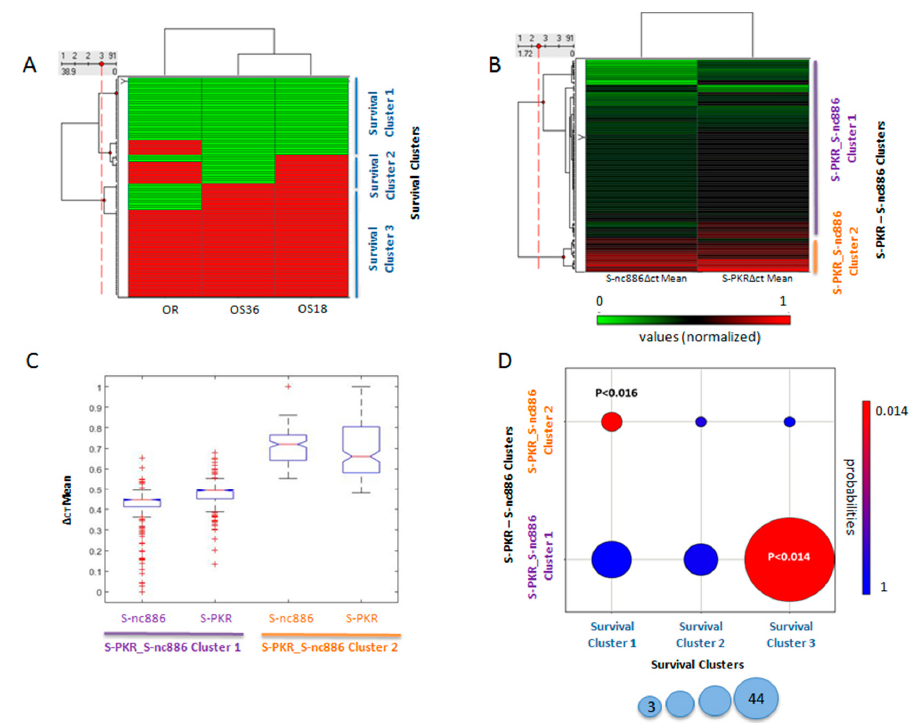
Figure 5. Correlation between the objective first-line chemotherapy response and the time-range patient survival with the ∆ ct mean values identified by RT qPCR in colon healthy (S) tissue. ( A ) Survival clusters: Biclusters of subjects according to their objective first-line chemotherapy response, and survival after 18 and 36 months. Values are coded as follows: negative response in green and positive response in red. ( B ) S-PKR-S-nc886 clusters: Biclusters of patients according to their ∆ ct mean values of nc886 and PKR in healthy tissue (S-nc886 ∆ ct mean, S-PKR). ∆ ct mean values are normalized between 0 (green) and 1 (red). ( C ) Boxplot of S-PKR and S-nc886 ∆ ct mean values in healthy tissue for each S-PKR-S-nc886 cluster. ( D ) Co-clustering between survival clusters and the S-PKR-S-nc886 clusters. p -values were calculated with hypergeometric statistics. Colour code for p -values’ statistical significance is indicated from high (red) to low (blue). The size of the circles indicates the number of individuals in the relationship.